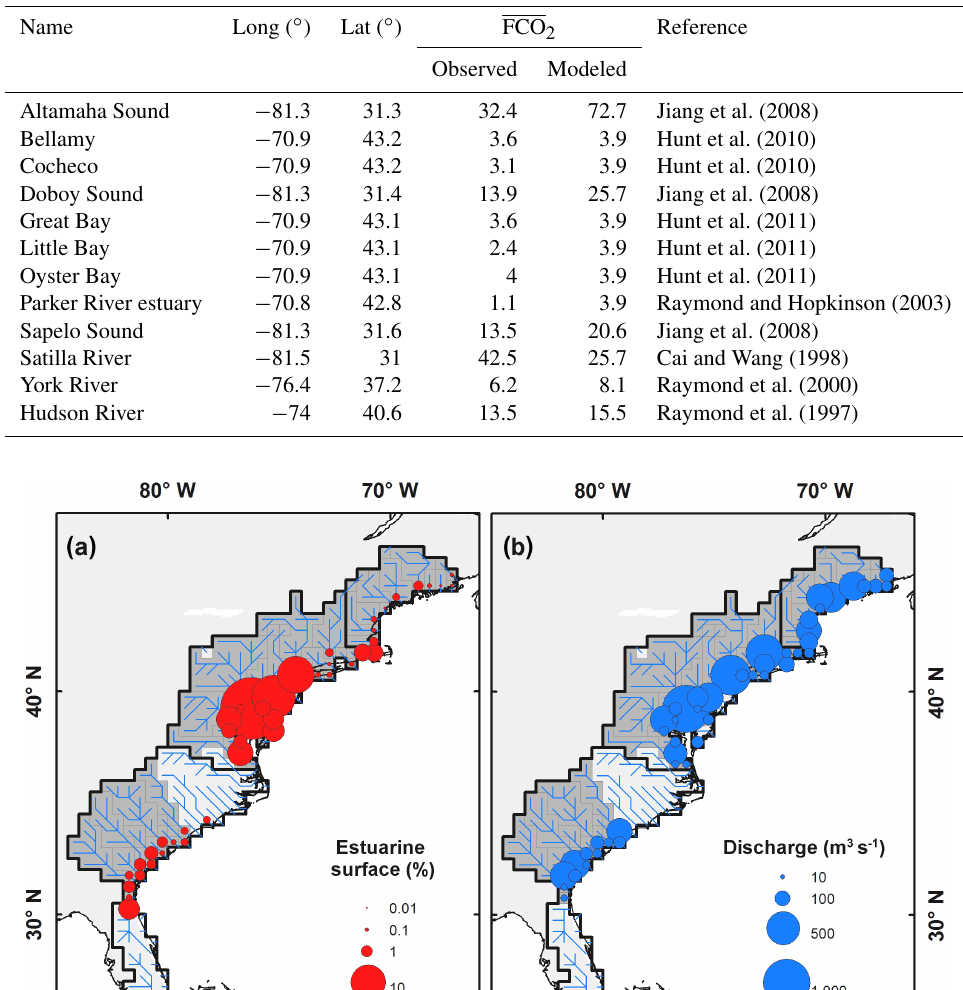
Table 2. Published local annually averaged estimates of FCO 2 inmol Cm − 2 yr − 1 for estuaries along the US East Coast.